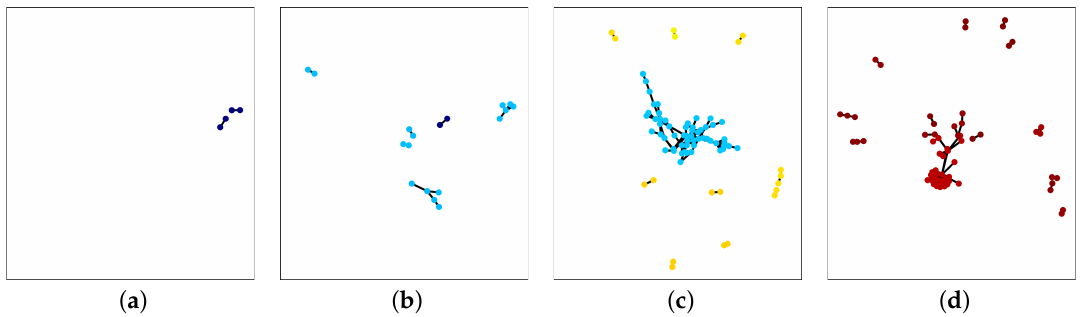
Figure 10. The simplicial complexes K 1 , K 34 , K 67 and K 100 corresponding to the temporal network described in Section 4.2 are visualised in ( a )–( d ), respectively. The number of 0-simplexes in each of these simplicial complexes is 4, 18, 75 and 66, respectively. The number of connected components in each of these simplicial complexes is 2, 6, 10 and 15,